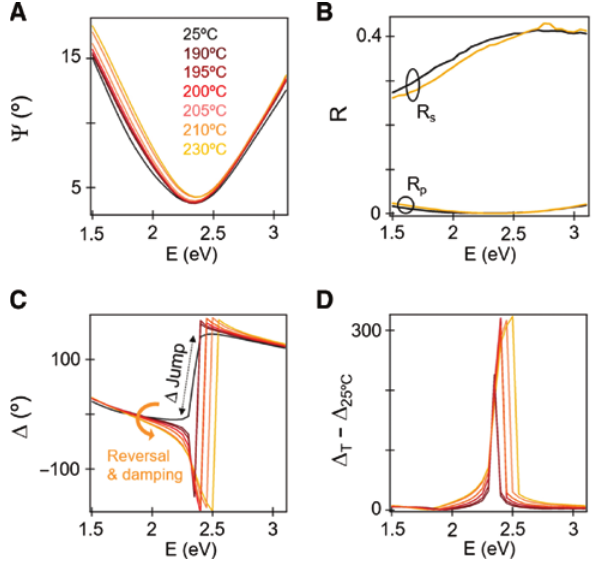
Figure 3: The broad and analog tuning of the phase of visible p-polarized light reflected by the Bi-based